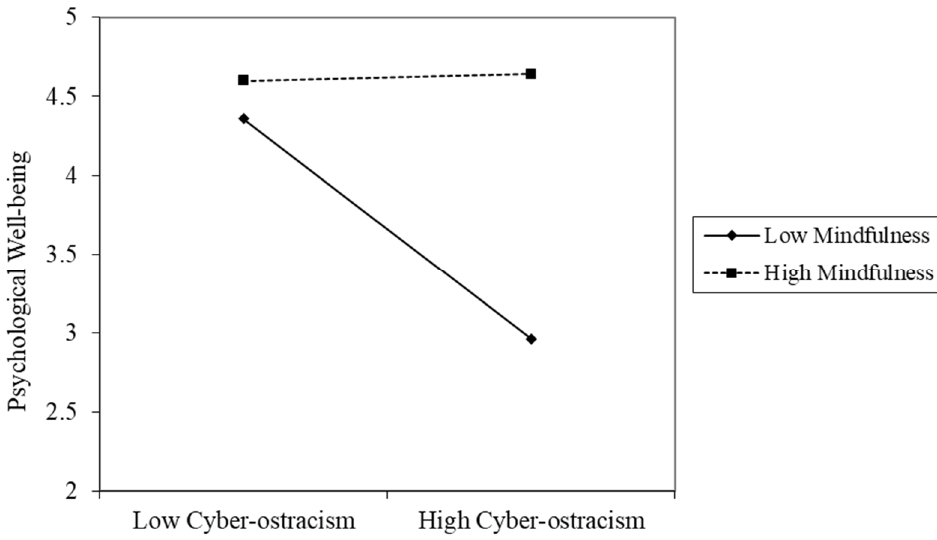
Figure 3. Mindfulness moderated the association between cyber-ostracism and psychological well- being.